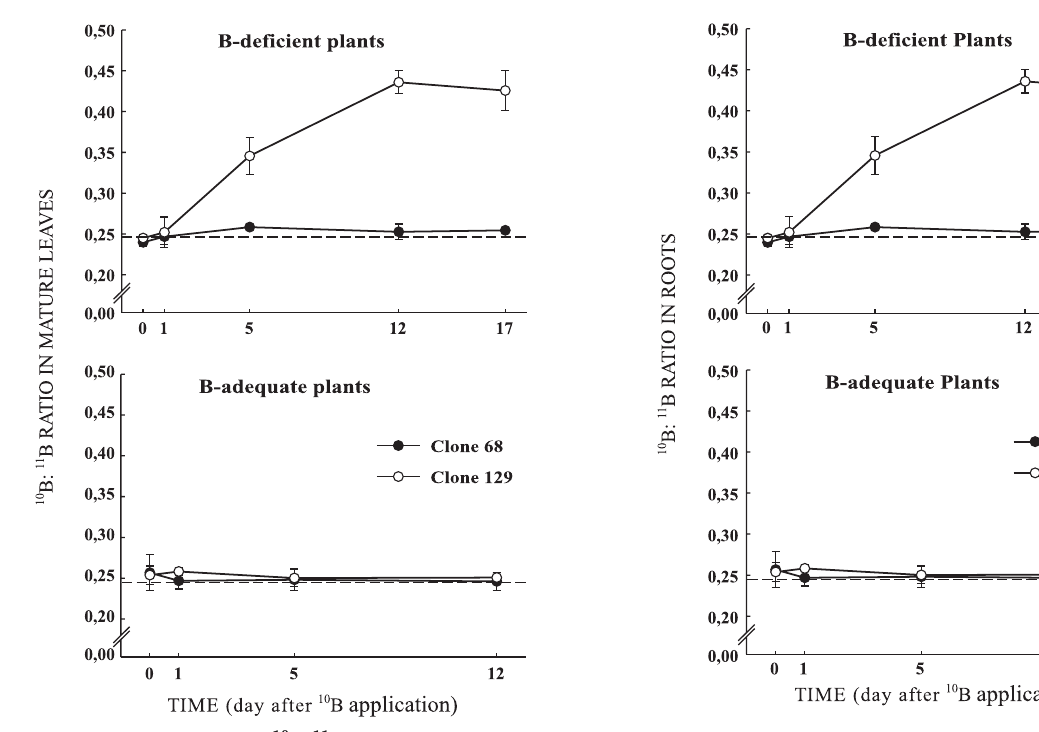
Figure 5. Isotope ratio of 10 B: 11 B in the roots over the course of time after 10 B application to a mature leaf of B-deficient and adequately supplied plants of two deficient eucalypt clones. The dashed line (----) represents the natural abundance of 10 B: 11 B = 0.247 of the certified standard NIST